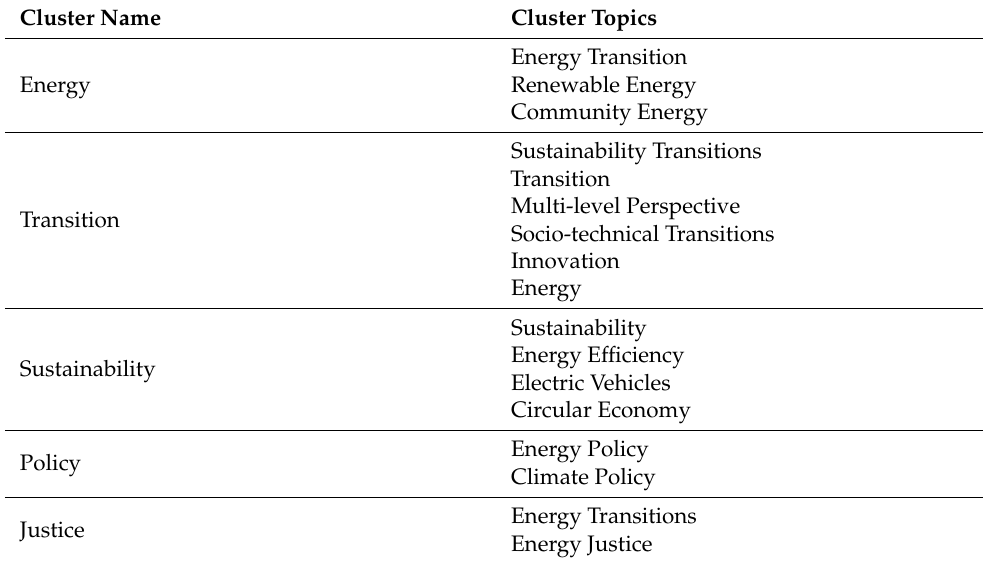
Table 4. Cluster themes of studies in the area of social innovation and energy transition.